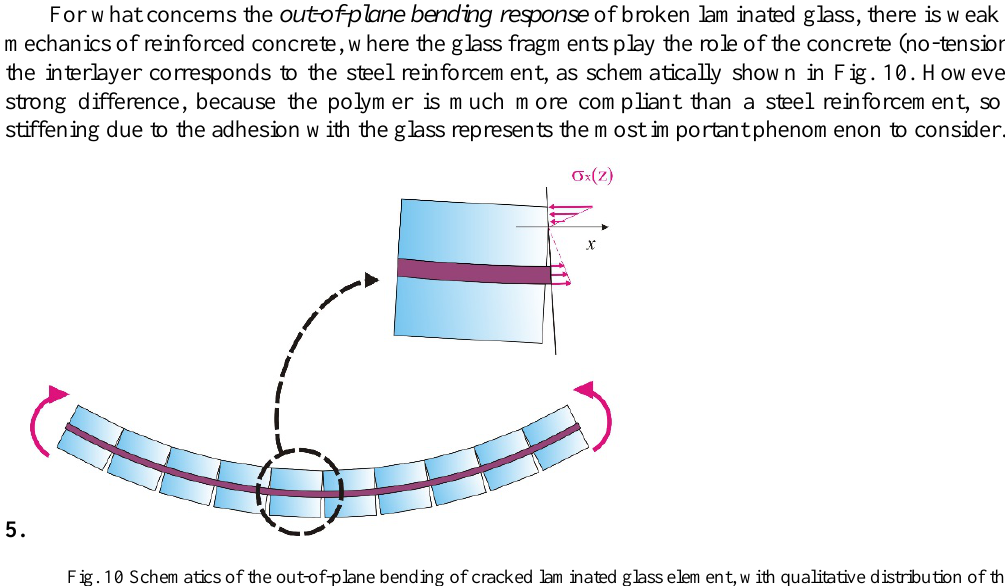
Fig. 10 Schematics of the out-of-plane bending of cracked laminated glass element, with qualitative distribution of the axial